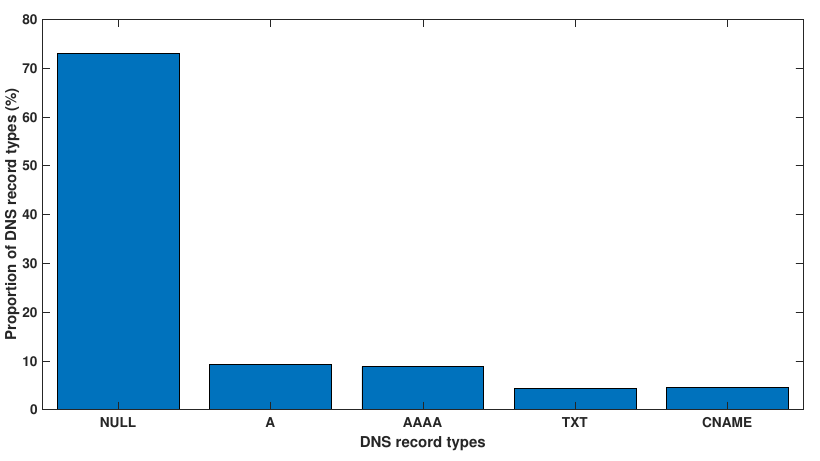
Figure 11. Proportion (%) of the different record types in the DNS